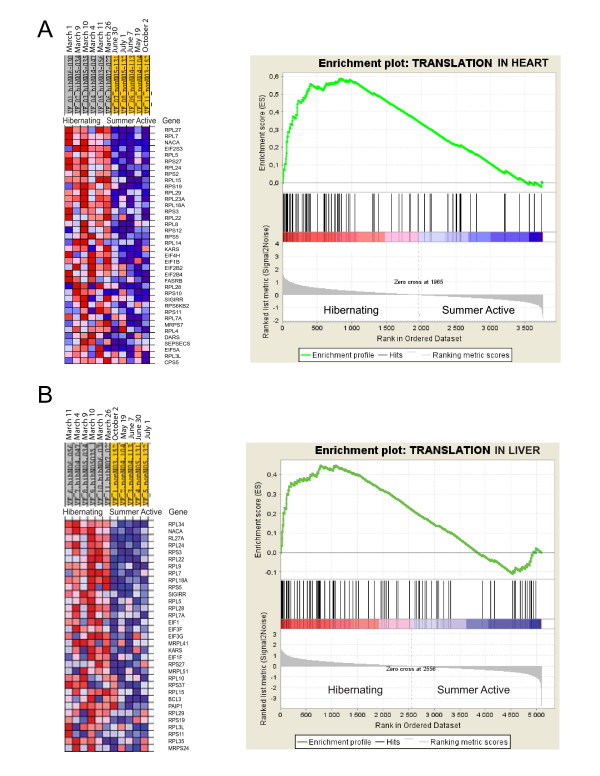
Gene set enrichment analysis results for the translation category. The translation category is enriched by up regulated genes in heart (A, false discovery rate (FDR) of <0.001) and liver (B, FDR = 0.046) of hibernating black bears. An expression data set sorted by correlation with hibernating phenotype and the corresponding heat map with red for up regulated and blue for down regulated genes during hibernation are shown on the left. Dates on the top indicate time of tissue sampling from each bear. Plot of the running sum for enrichment score (ES) in the data set (top) and location of genes (hits) from each GO category in the list ranked according to expression differences (middle) and the ranked list metric (bottom) are shown on the right.